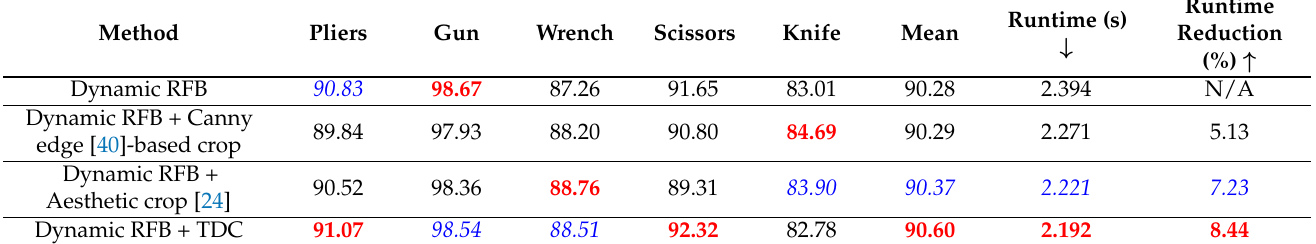
Table 4. Detector performance on SIXray-D datasets using dynamic shape input RFB Net (Dynamic RFB) after applying different cropping methods. Red indicates the best results and blue indicates the second best